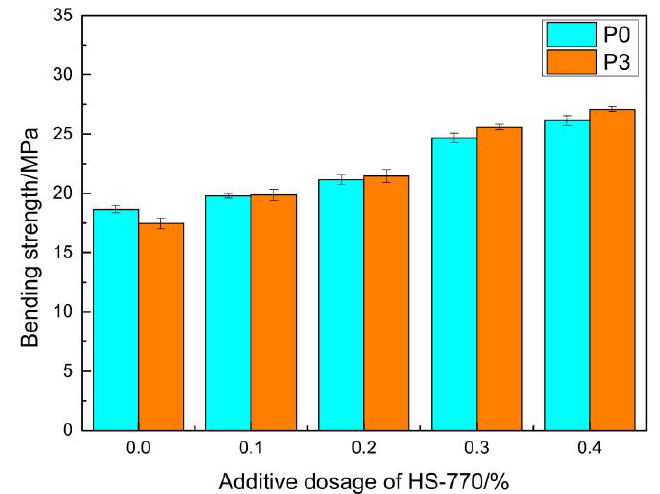
Figure 9. The effect of HS-770 content on bending strength.